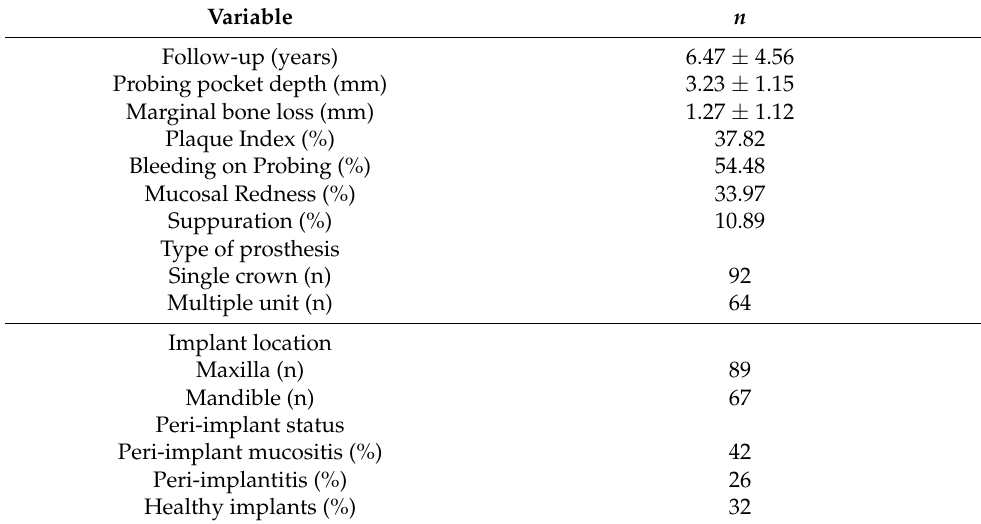
Table 1. Implant characteristics of patients enrolled.